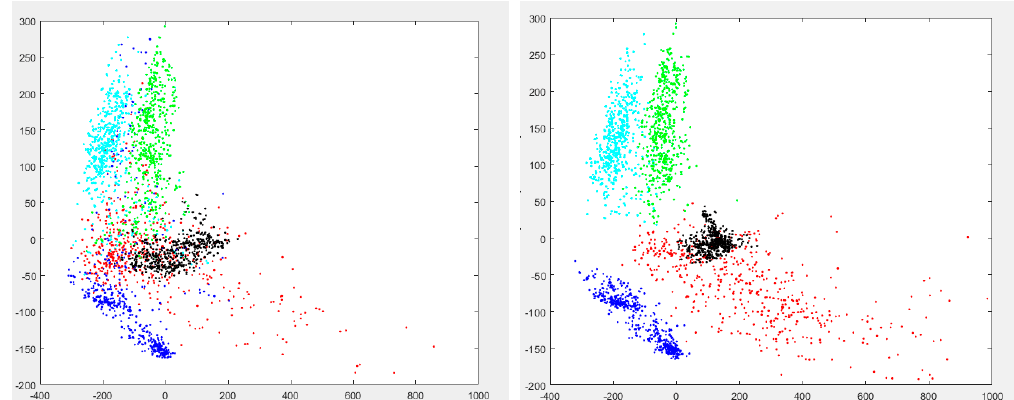
Figure 5. Comparison between the class distribution of the original OpenStreetMap (OSM) samples (left) and the samples generated by the proposed method (right) (buildings = red, water = blue, forests = cyan, grasses = green, soils = black).